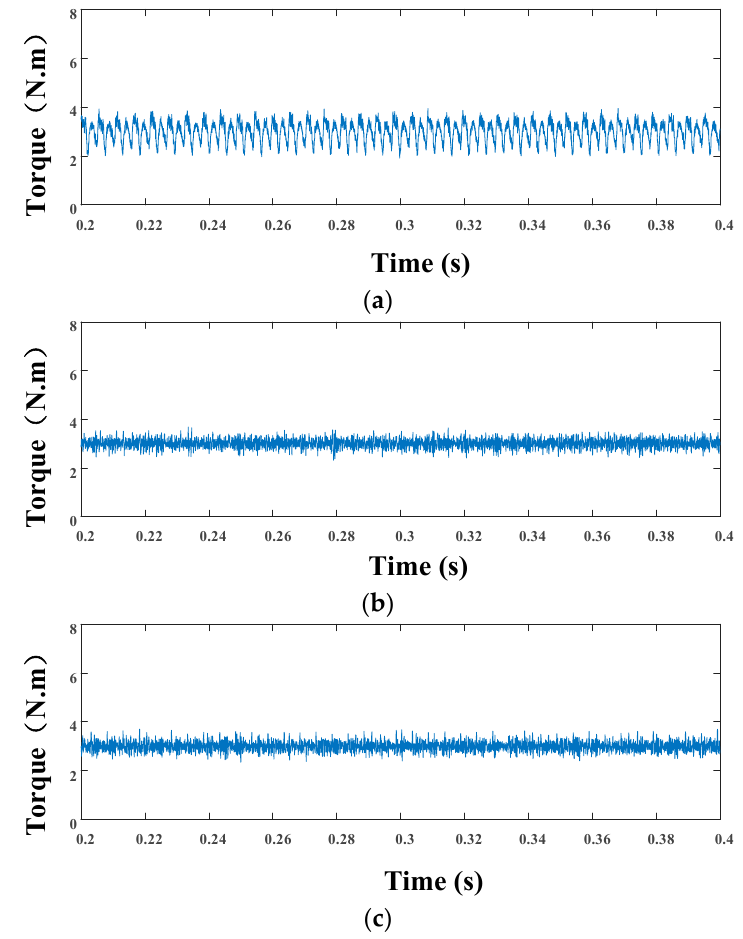
Figure 10. Simulated torque waveforms under different control strategy in speed of 500 rpm and load torque of 3 Nm: ( a ) traditional control strategy; ( b ) proposed three-phase current commutation strategy in phase-change angle α of 20°; ( c ) proposed three-phase current commutation strategy in phase-change angle α of 6.5°.